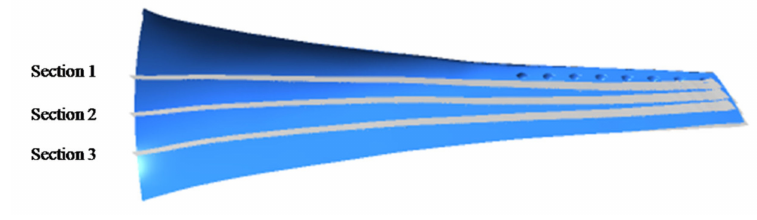
Figure 9. Schematic diagram of streamwise